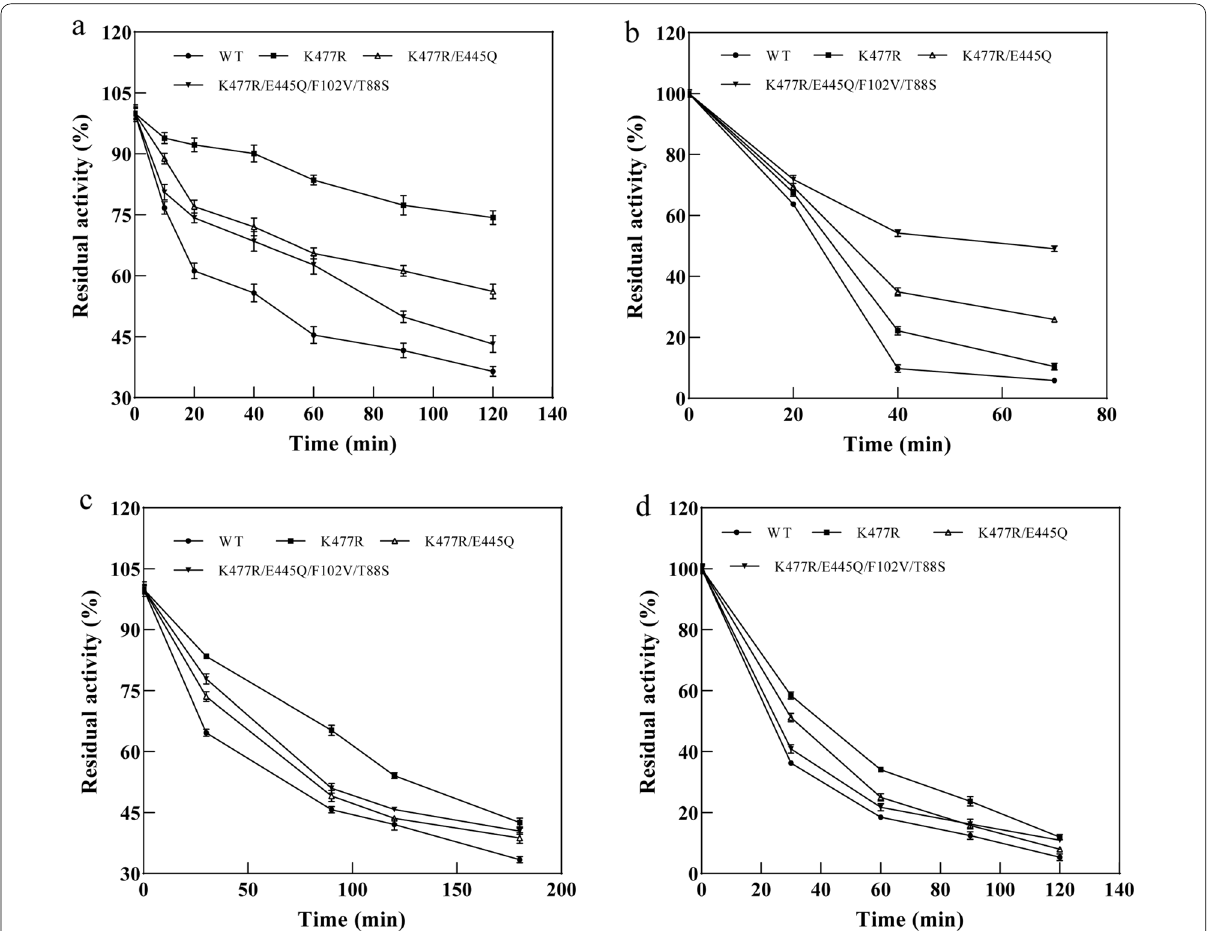
Fig. 5 Thermostability and pH stability of the wild-type CadA and its mutants. a Residual activities of mutants and the wild-type CadA after incubation at 60 ºC. b Residual activities of mutants and the wild-type CadA after incubation at 70 ºC. c Residual activities of mutants and the wild-type CadA after incubation at pH 8.0 and 50 ºC. d Residual activities of mutants and the wild-type CadA after incubation at pH 9.0 and 50 ºC. The initial activities without incubation were set as 100%. The error bars represent standard deviations calculated from triplicate